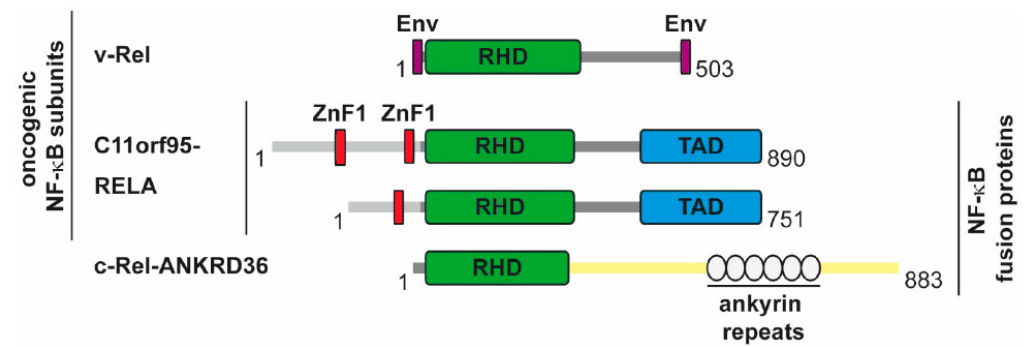
Figure 5. Schematic summary of oncogenic NF- κ B DNA-binding subunits. The color code is similar to Figure 1, the v-Rel protein contains short sequence remnants from the REV env (envelope) gene at the N- and C-termini. Different parts of the C11ORF95 proteins, which contain zinc fingers (ZnF) are fused to the N-termini of p65.